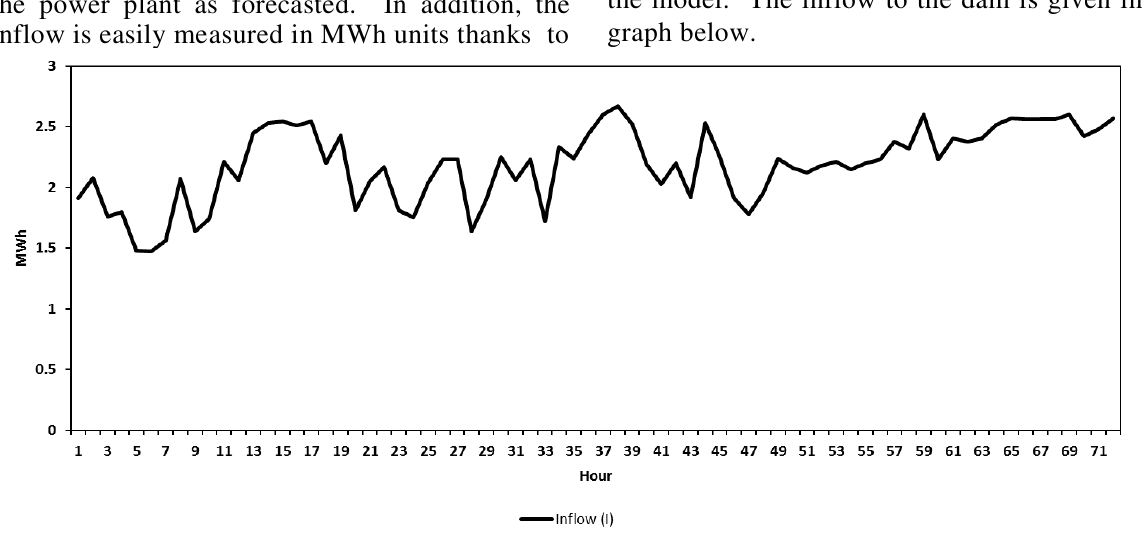
Fig. 4. Water inflow forecasts (after Mro is deducted) for the given